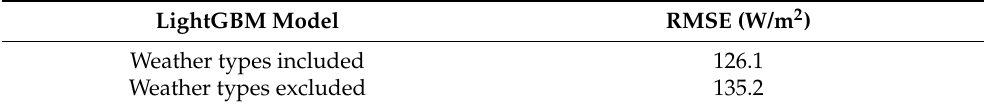
Table 6. The RMSE of the LightGBM model test set with or without weather